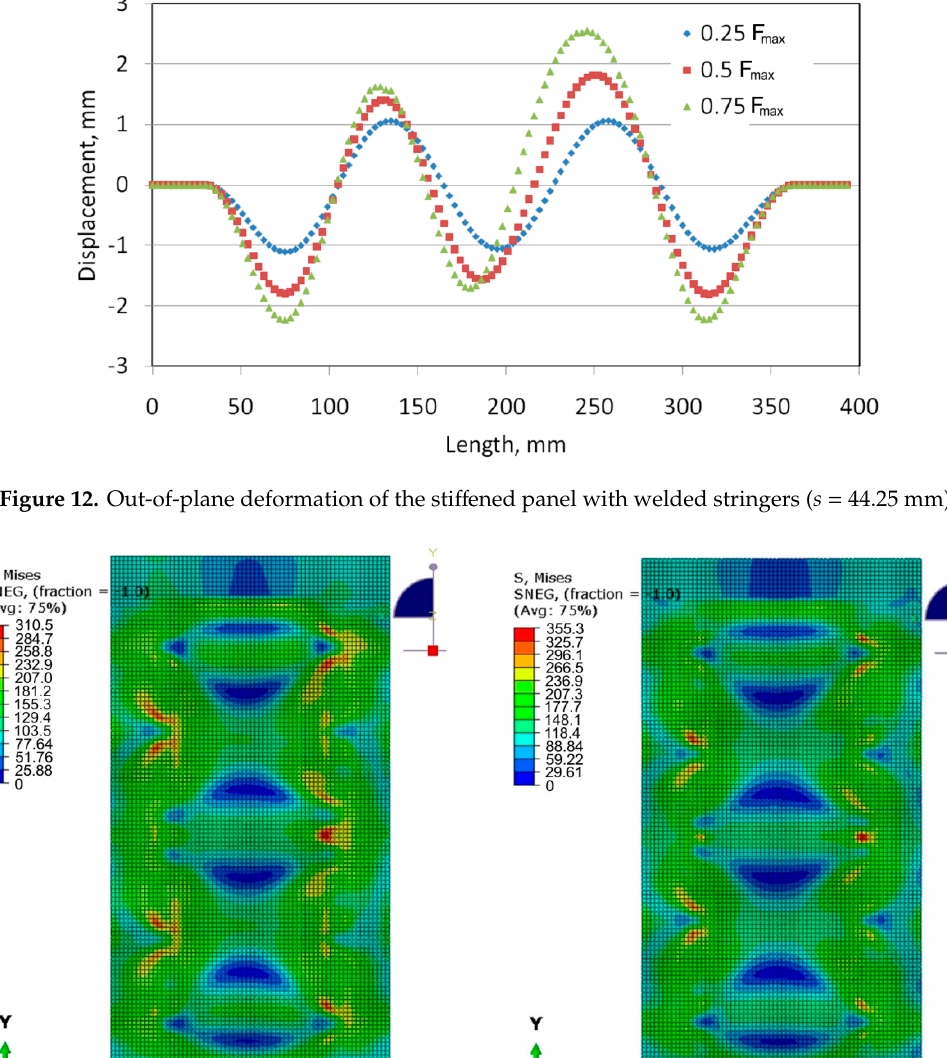
Figure 11. Out ‐ of ‐ plane deformation of the stiffened panel with welded stringers ( s = 29.5 mm).